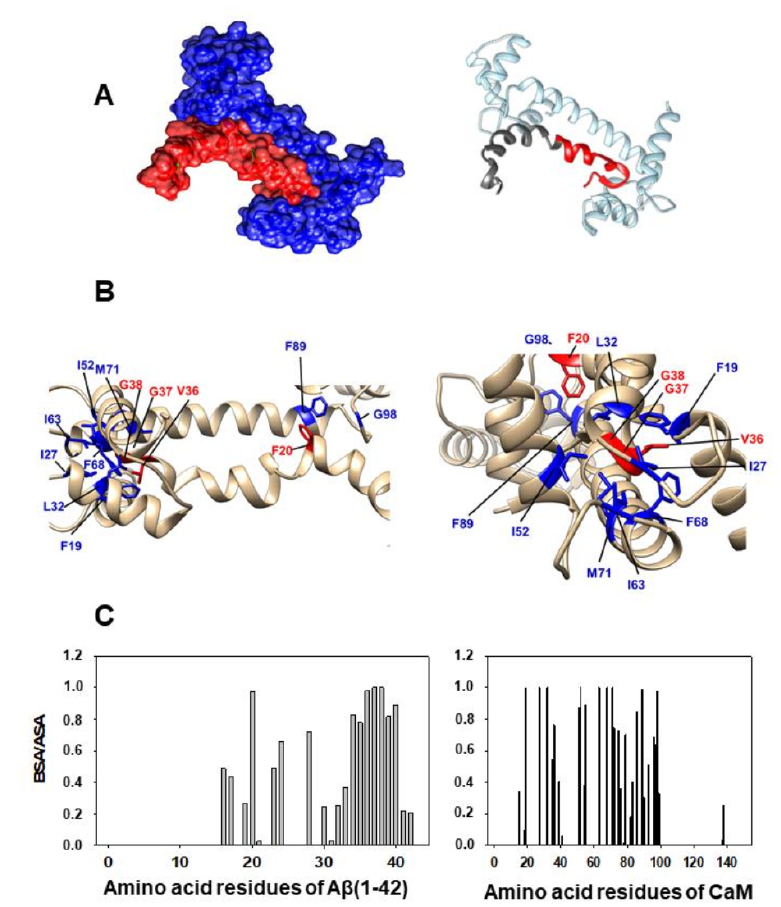
Figure 2. The selected in silico model structure 1 of the complex A β (1–42):CaM obtained using the PDB ID files: 1Z0Q for A β (1–42) and 1CLL for Ca 2+ -saturated CaM. Docking was performed as indicated in the Materials and Methods section. ( A ) The space-filled and peptide and protein backbone images of the complex. A β (1–42) is stained in red and CaM is stained in blue in the space- filled image. The protein backbone of CaM is stained in light blue, the 24–42 amino acid residues of A β (1–42) are stained in red, and the rest of the A β (1–42) is stained in dark grey. ( B ) The structural details of the A β (1–42):CaM interface of in silico model structure 1: a side view on the left and a front view on the right. The CaM amino acid residues (colored in blue) more strongly interact with the 24–42 amino acid residues of A β (1–42) (colored in red). ( C ) Graphic charts of the BSA/ASA values obtained for the amino acids residues of A β (1–42) and CaM in the in silico model structure 1 of the A β (1–42):CaM